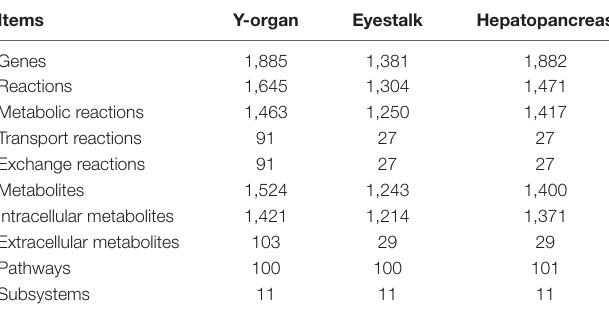
TABLE 7 | Basic features of the eyestalk and Y-organ GSMN.